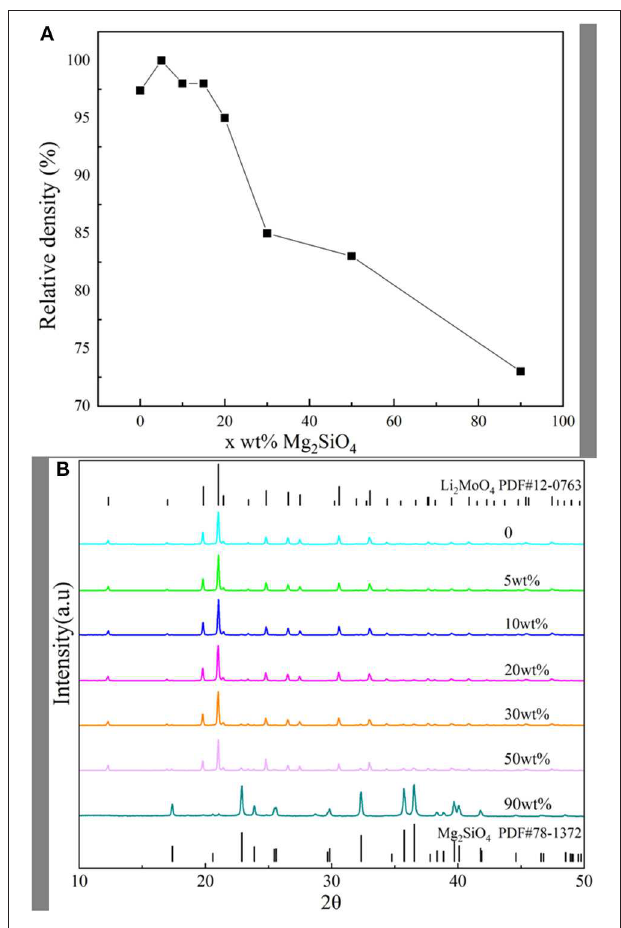
FIGURE 1 | (A) Relative densities and (B) XRD patterns of (1-x) LMO-xMSO composite ceramics.